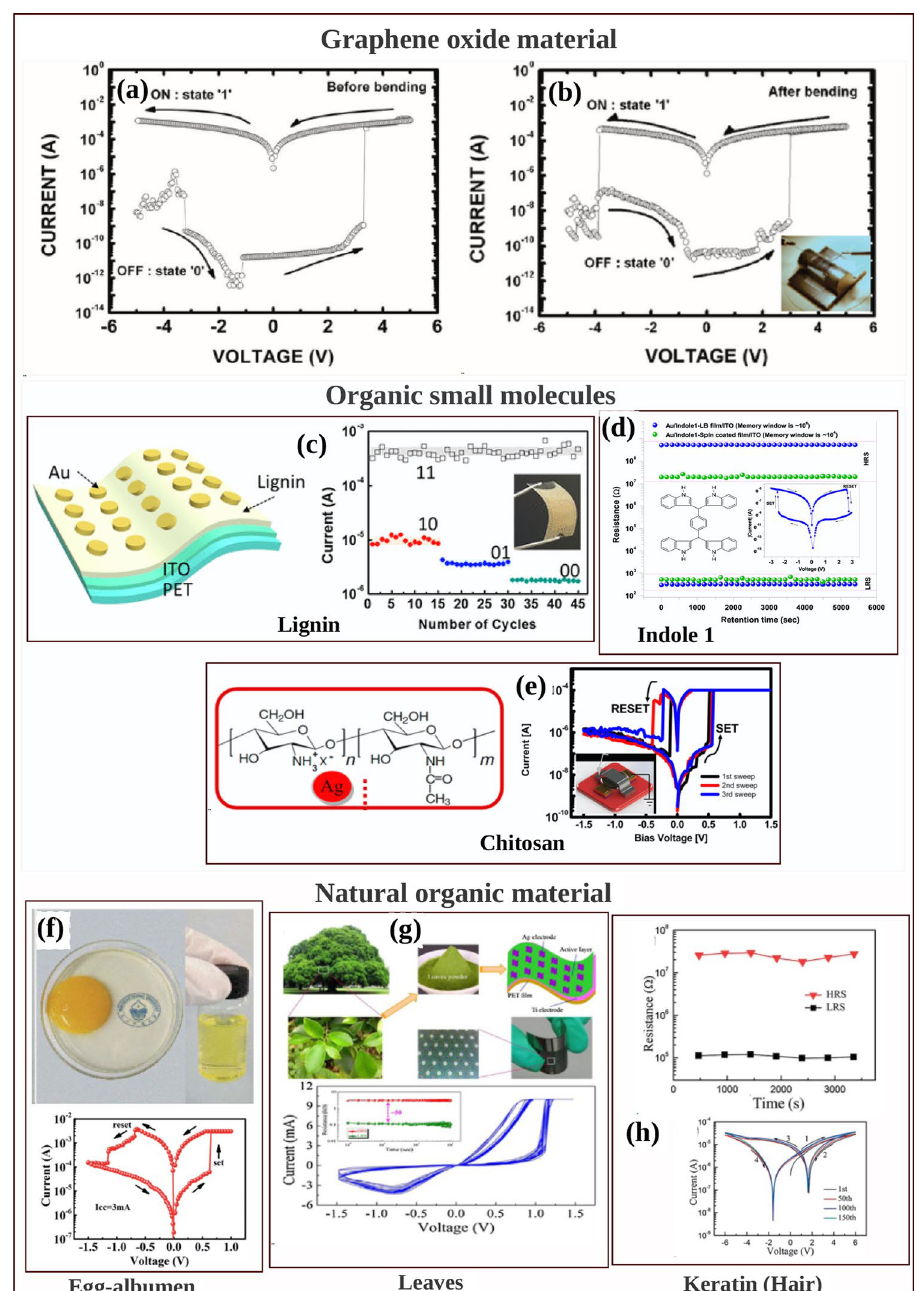
Fig. 20 Organic materials with resistive switching. a Flexible graphene-based RRAM of Al/PMMA/graphene/PMMA/ITO/PET before bend- ing. b The Al/PMMA/graphene/PMMA/ITO/PET after bending surface curvature radius (R) of 10 mm. c The structure of Au/lignin/ITO RRAM device and multilevel resistance characteristics of the device. d The chemical structure of the indole 1 molecule, the I–V curves and the retention time of the Au/Indole1/ITO RRAM device. Blue depicts the LB film and green represents the spin-coated film. e The Ag-doped chitosan device unit and the I–V characteristics of the chitosan-based RRAM device with AgNO 3 concentration. f Chicken egg, extracted egg albumen and typical electrical characteristics curves of the Ag/egg albumen/ITO/PET. g The preparation process of the plant leaves- based RRAM device, the retention time and the I–V characteristics curve of the developed Ag/Leaves/Ti/PET device. h The I–V resistive characteristics curves of Ag/keratin/ITO RRAM device and good retention time. a , b Reprinted with permission [240] Copyright Jul 2010, American Chemical Society. c Reprinted with permission [241] Copyright Feb 2017, American Chemical Society. d Reprinted with permission [220] Copyright Apr 2021, American Chemical Society. e Reprinted with permission [242] Copyright Jan 2015, American Chemical Society.